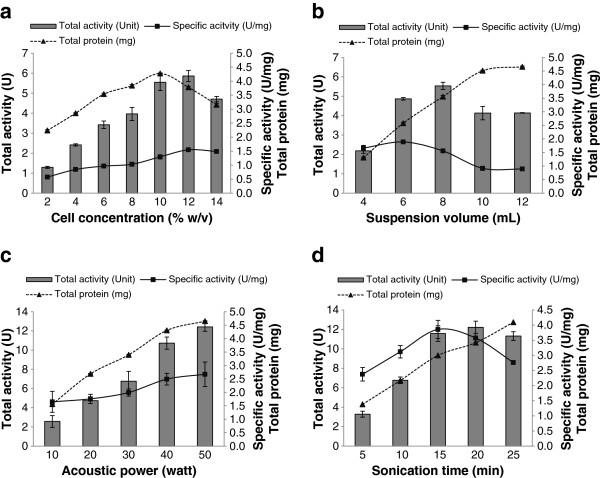
Optimization of sonication protocols on the recovery of GAD. (a) Effect of cell concentration (% w/v) on GAD release by suspending the mycelia in 10 mL of citrate buffer at pH 5.5 and sonicated at 20 Khz, 50 W for 10 min; (b) Effect of buffer suspension volume (mL) on GAD release by sonicate 10% (w/v) of mycelia at 20 Khz, 50 W for 10 min; (c) Effect of acoustic power (watt) on GAD release by suspending mycelia (10% w/v) in 10 mL of citrate buffer at pH 5.5 and sonicated at 20 Khz for 10 min; (d) Effect of sonication time (min) on GAD release by suspending mycelia (10% w/v) in 10 mL of citrate buffer at pH 5.5 and sonicated at 20 Khz and 50 W. Results represent the mean (± SD) of three experiments.